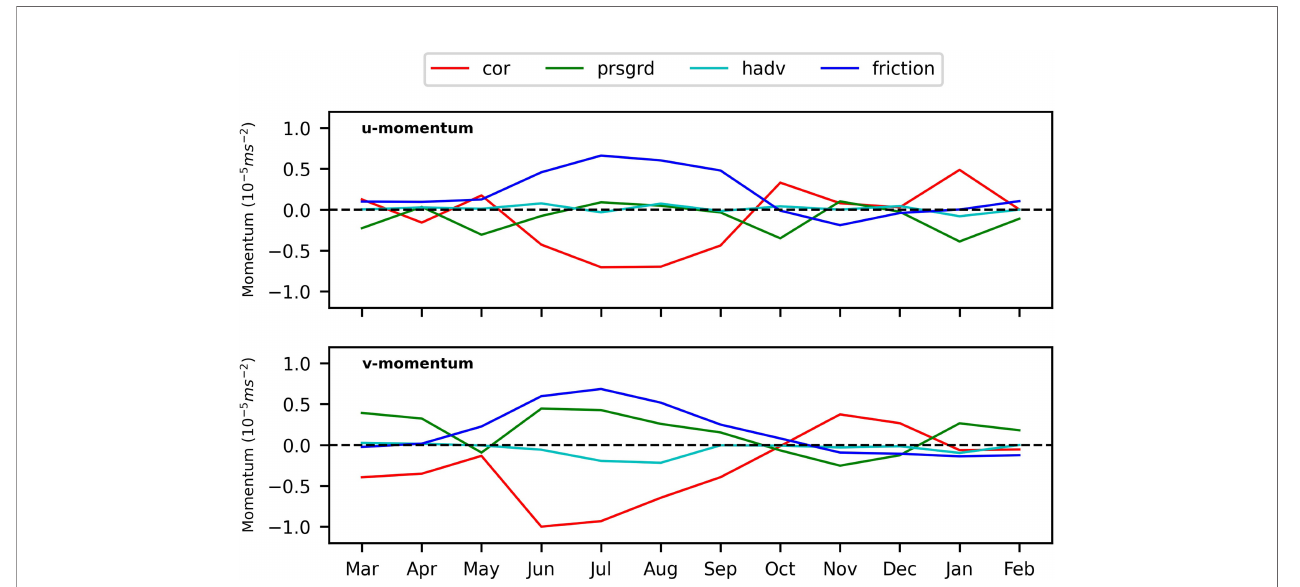
FIGURE 9 | Annual cycle of the four momentum terms namely Coriolis(red), pressure gradient(green), horizontal advection(cyan) and wind friction(blue) at a point (black dot in Figure 4D ) in IR jet. Upper panel shows the annual cycle of momentum terms from the zonal momentum (u-momentum equation) and the lower panel shows the annual cycle of the meridional momentum (v-momentum equation). All terms are averaged over the fi rst fi ve levels from the